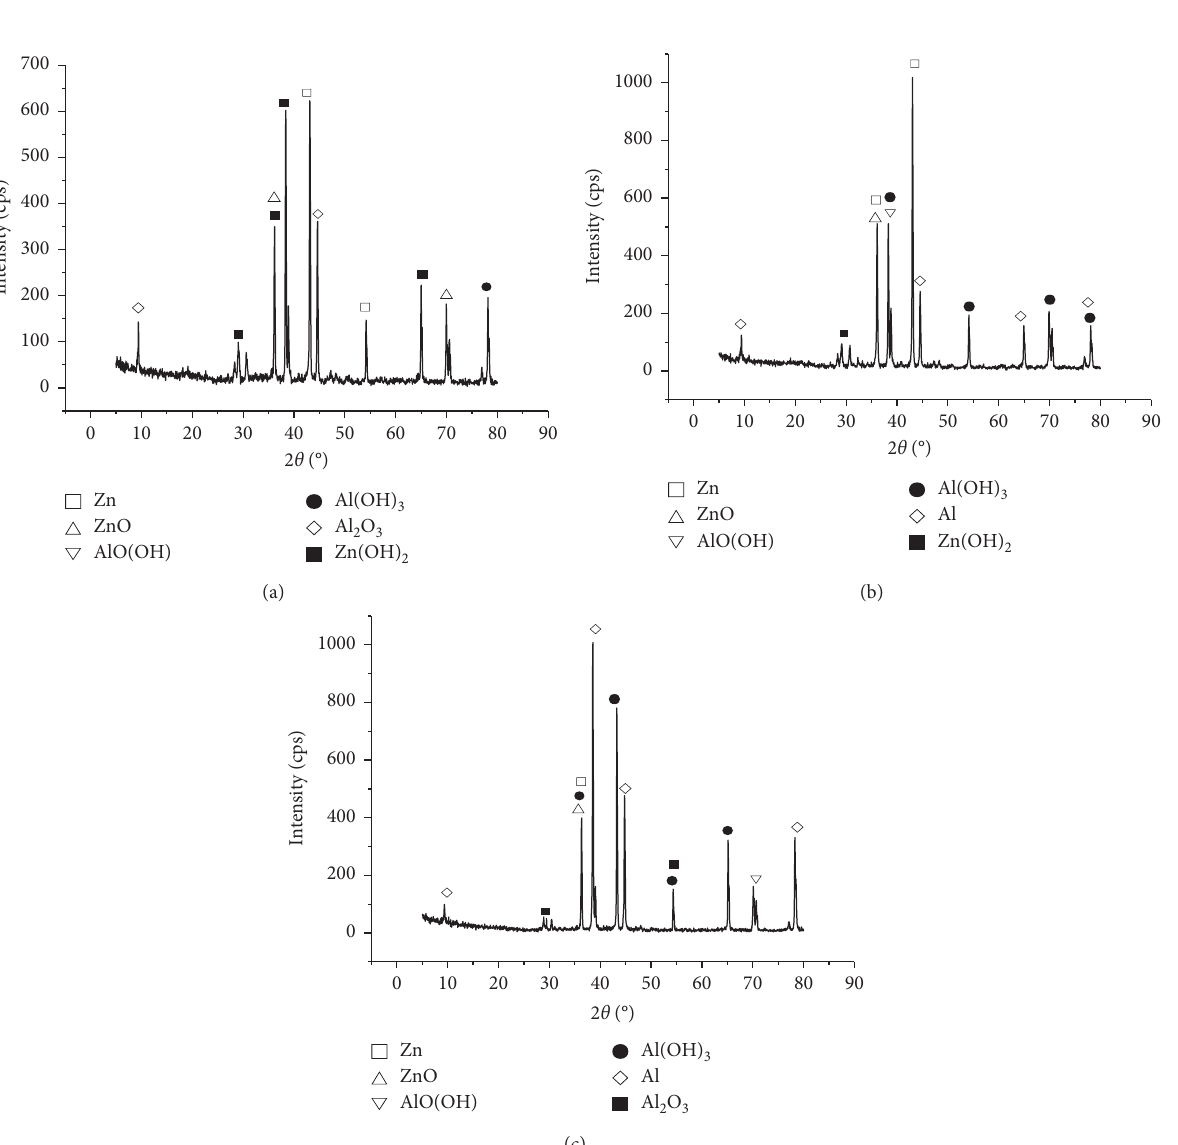
Figure 11: XRD diagrams of three coatings after corrosion: (a) 20% Al-80% Zn, (b) 30% Al-70% Zn, and (c) 40% Al-60%